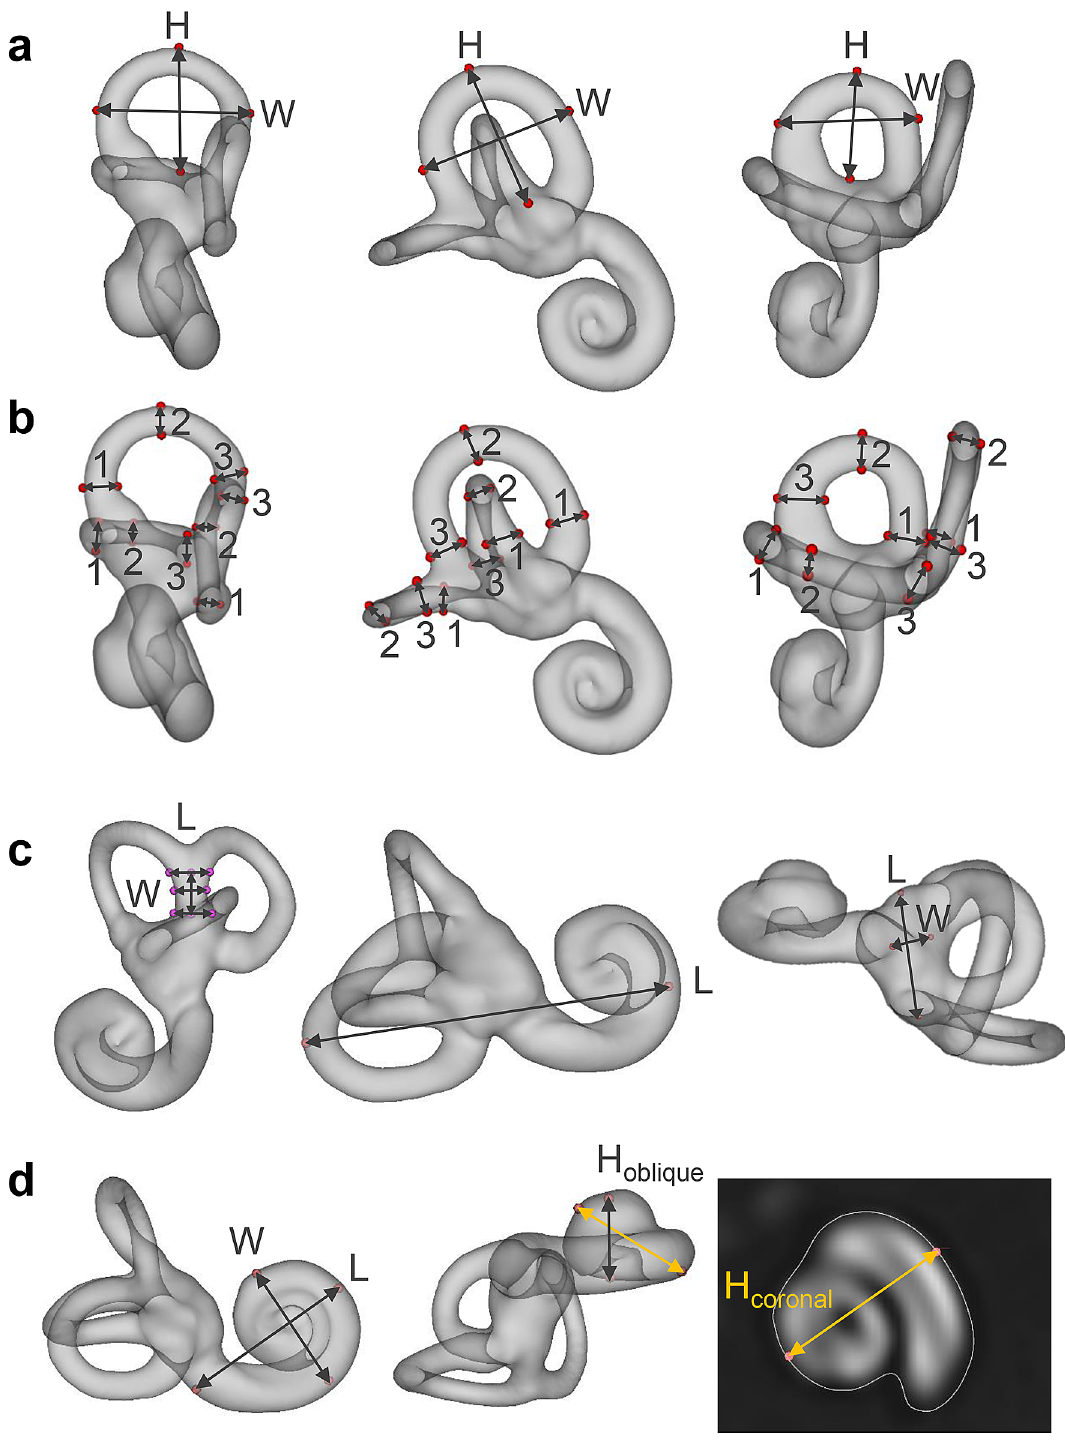
Figure 5. Inner ear landmark annotations in template space. Panel ( a ) width and height of the anterior (left), posterior (middle) and lateral (right) semicircular canals. Panel ( b ) inner widths and heights of semicircular canals, measured at three locations each (1–3). Panel ( c ) height and three widths of the common crus (left), total inner ear length (middle), and vestibule length and width (right). Panel d: width, length and height of the cochlea. Cochlea height was tagged and measured using both the coronal plane approach (gold arrow) 51,52 , and the oblique plane (i.e. 3D) approach (grey arrow) 53 . H = height, W = width, L = length. (Figure panels created with 3D Slicer, v4.11 (https ://www.slice